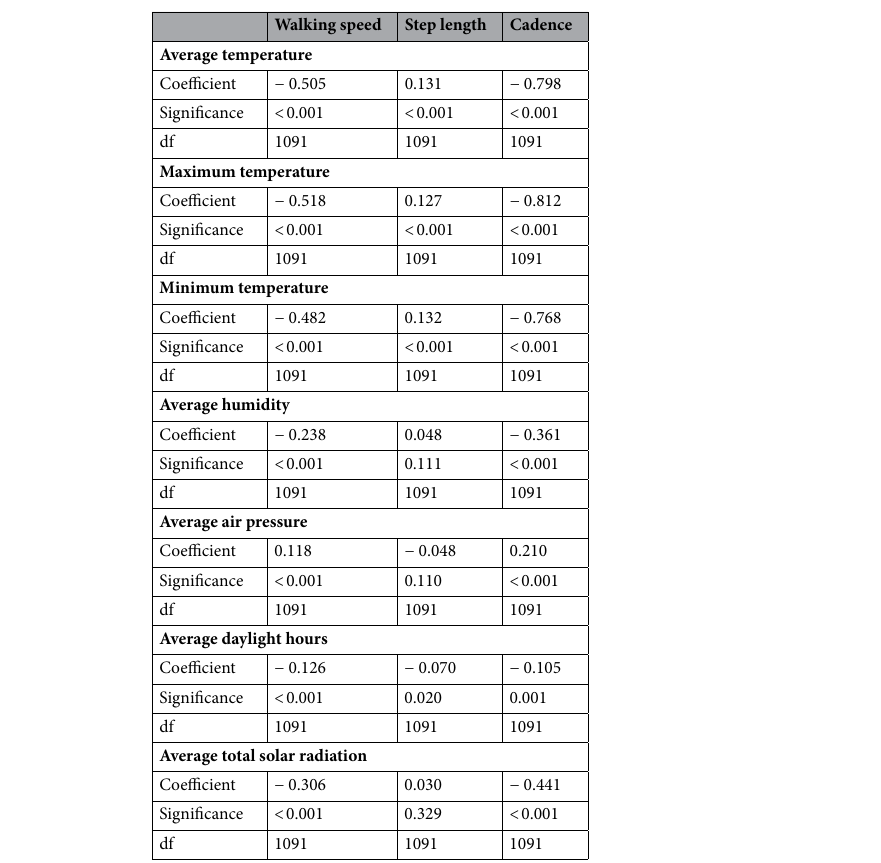
Table 2. Walking parameters and meteorological variables correlation coefficients. Control variable: